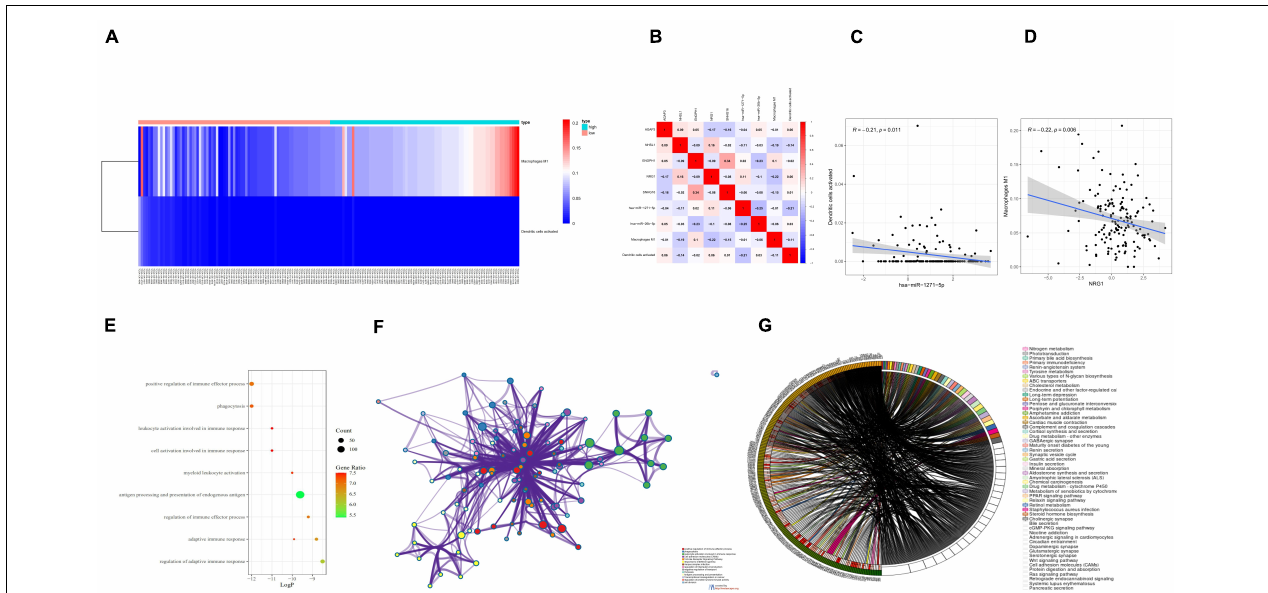
FIGURE 8 | (A) Heatmap of the differential expression of two immune cells in the high- and low-risk groups. (B) Prognostic-related molecules and cell correlation analysis results. (C) Dendritic cells activated and hsa-miR-1271-5p molecules. Correlation analysis results of (D) macrophage M1 cells and NRG1 molecules. (E) Bubble chart of GO enrichment analysis of prognostic-related genes. (F) Network chart of GO enrichment analysis of prognostic-related genes. (G) Circle diagram of KEGG enrichment analysis of prognostic-related genes.